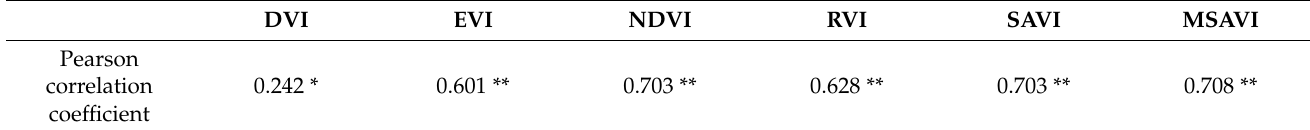
Table 5. Correlation coefficient matrix for vegetation indices and CC.